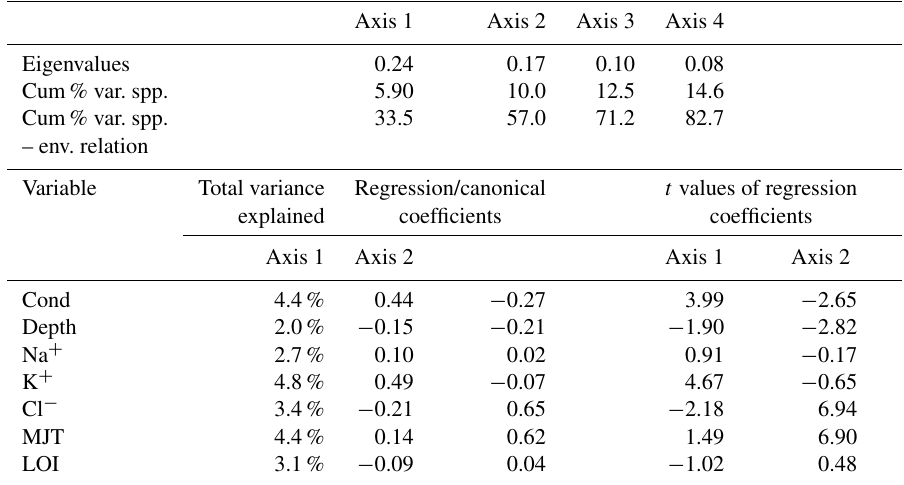
Figure 3. CCA biplots of sample and species scores constrained to environmental variables that individually explain a significant ( p <0.05) proportion of the chironomid species data. (a) Species and (b) sample scores constrained to seven significant environmental variables in the 100 lakes of southwestern China. The species codes are correspondent to the taxon names shown in Fig. 2a. Table 2. CCA summary of the seven significant variables ( p <0.05) including canonical coefficients and t values of the environmental variables with the ordination axes including 100 lakes and 85 non-rare